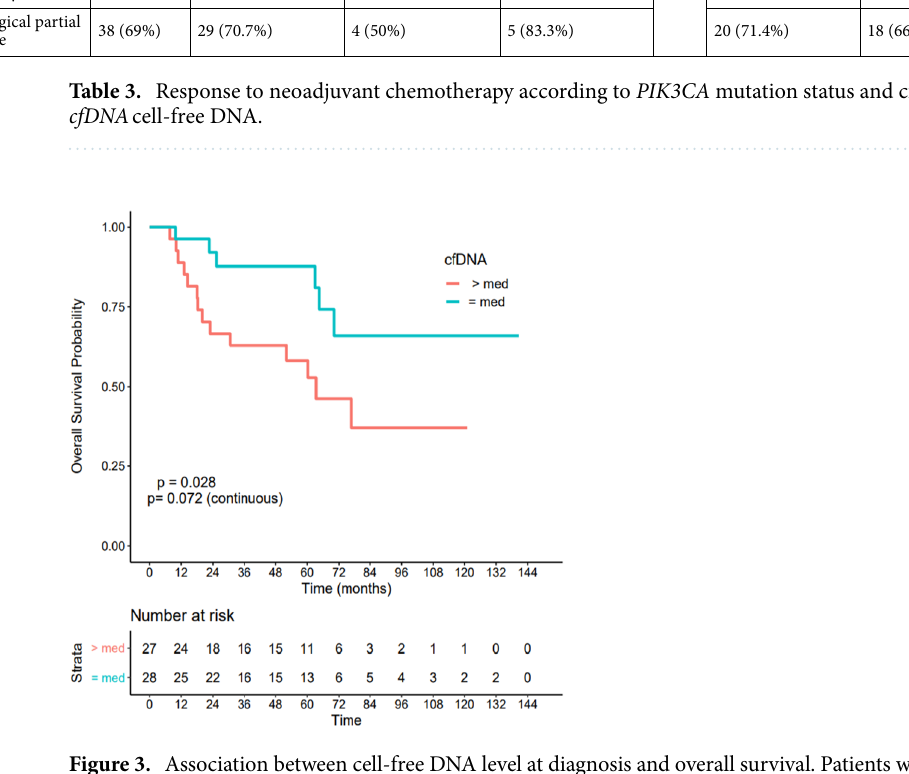
Figure 3. Association between cell-free DNA level at diagnosis and overall survival. Patients with cfDNA below the median had a significantly better OS outcome (HR = 0.36 CI[0.14–0.93], p =